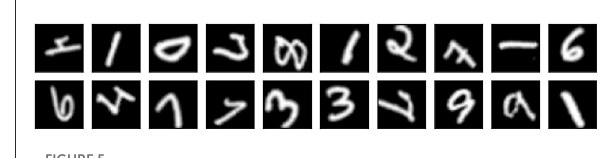
FIGURE5 Examples from our augmented MNIST training